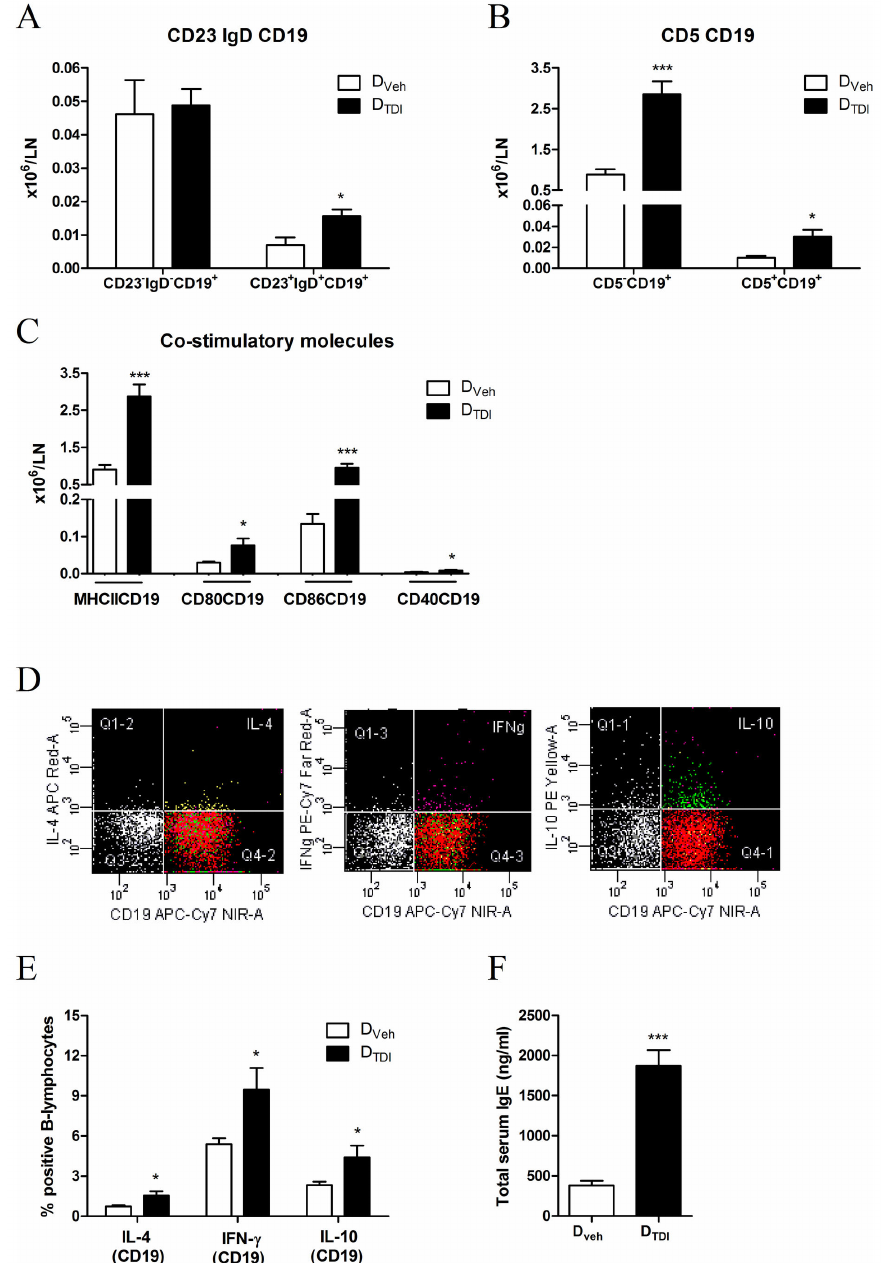
Figure 1. Total serum IgE in donor mice along with surface markers and cytokine production by B-lymphocytes of the auricular lymph nodes. Serum and lymphocytes from the auricular lymph nodes were obtained of mice dermally treated with vehicle (D ) or TDI (D ). The lymphocytes were stained with anti-CD19 to identify B lineage cells and for different surface markers Veh TDI and co-stimulatory molecules. CD19 + -lymphocytes were co-stained with anti-CD23 and anti-IgD to distinguish between follicular and marginal zone B-lymphocytes (A); co-stained with CD5 to distinguish between B1- (B1a) and B2-lymphocytes (B) and co-stained with MHCII, CD86, CD80 and CD40 to characterize the antigen presentation capacity of the B-lymphocytes (C). Lymphocytes of auricular lymph nodes were cultured in vitro for 5 hours with PMA, Ca 2+ ionophore and monensin. Anti-CD19 was used to identify B lineage cells and the percentage B-lymphocytes staining intracellularly for the cytokines IL-4, IFN-γ and IL-10 was assessed. Figure 1 D shows representative dot plots of intracellular cytokine expression in B-lymphocytes from TDI-sensitized mice. The percentage of the total B-lymphocytes expressing cytokines is quantified in graph E. In the serum of D or D mice, total IgE levels were veh TDI measured (F). Data are presented as means ± SEM, n = 4-5, * p < 0.05 and *** p < 0.001. doi: 10.1371/journal.pone.0083228.g001 PLOS ONE |